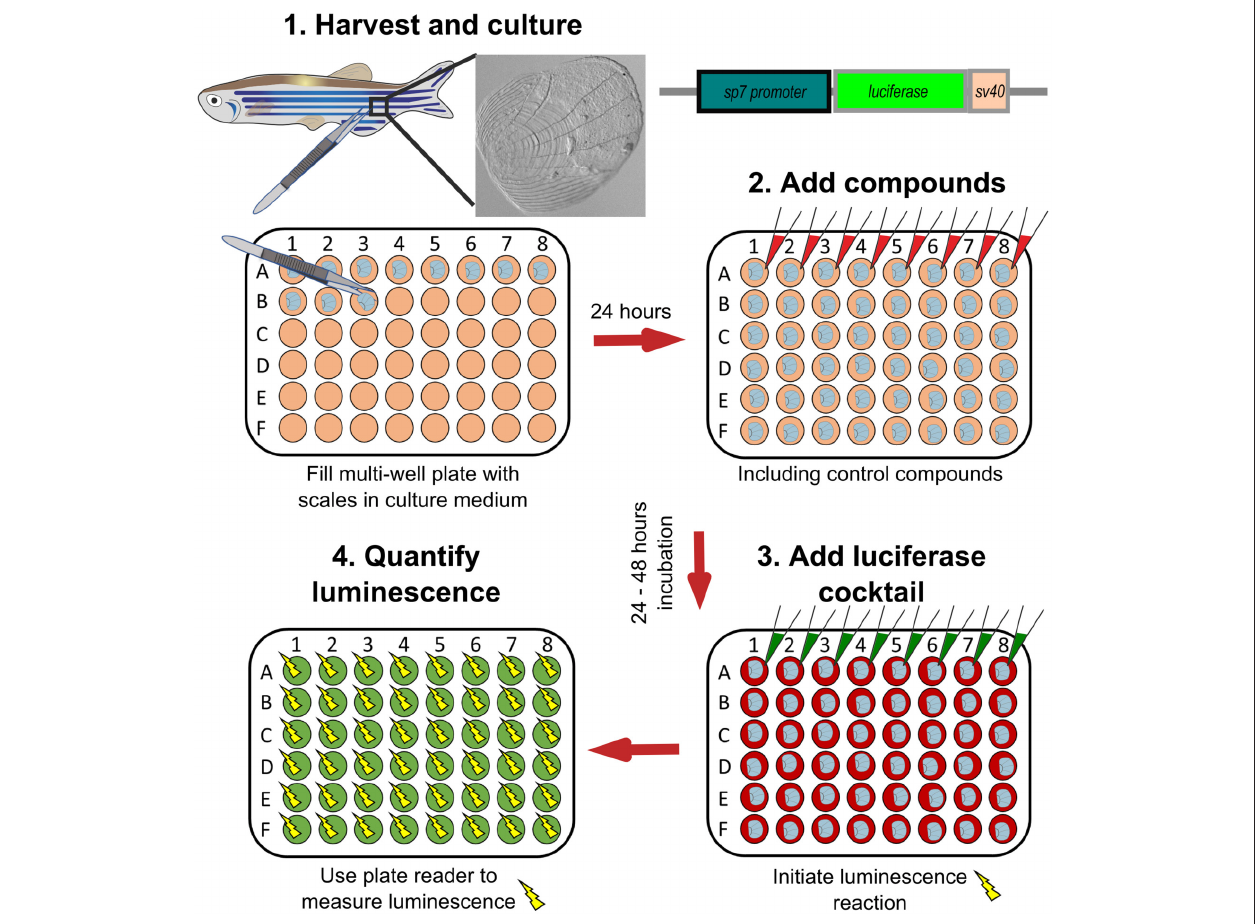
FIGURE 6 | Schematic representation to show how osteoblast activity can be quantified from scales . Scales from sp7:luciferase transgenic reporter fish are harvested from the lateral flanks of a fish, then cultured in multi-well plates with DMEM culture medium (orange wells) at 28 ◦ C for 24h. Compounds of interest can then be added (red wells) to the scales and incubated prior addition of a luciferin cocktail (green wells) and measurement of luciferase activity with a luminescent (yellow sparks) plate reader. Based on text from de Vrieze et al. (